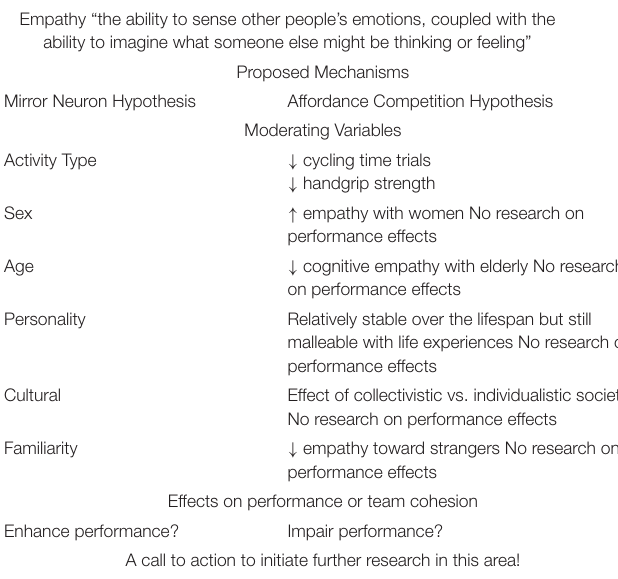
TABLE 1 | Empathetic effects on performance: research summary. Empathy “the ability to sense other people’s emotions, coupled with the ability to imagine what someone else might be thinking or